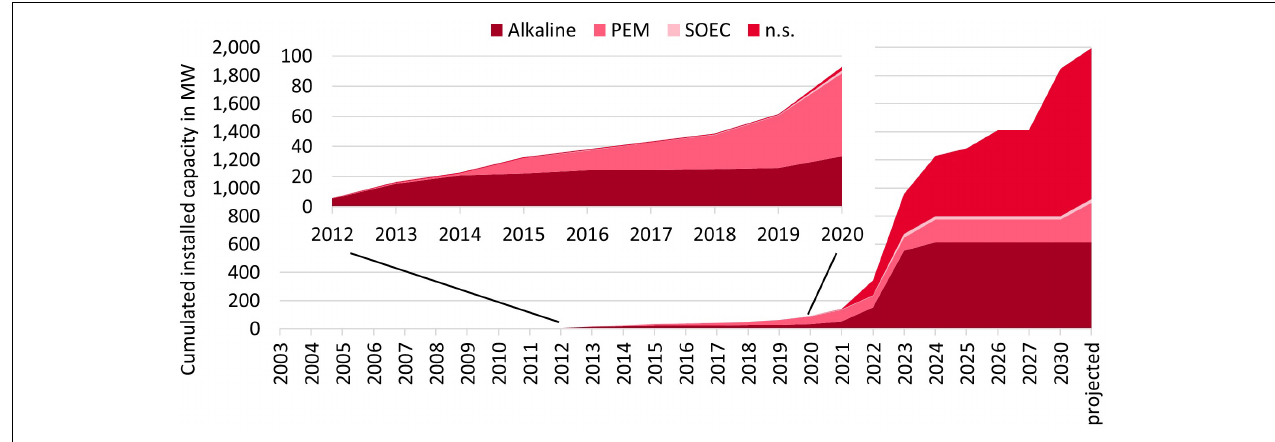
FIGURE 6 | Cumulative installed capacity according to electrolyzer type. n.s., not specified; PEM, polymer electrolyte membrane; SOEC, solid oxide electrolyzer cell.